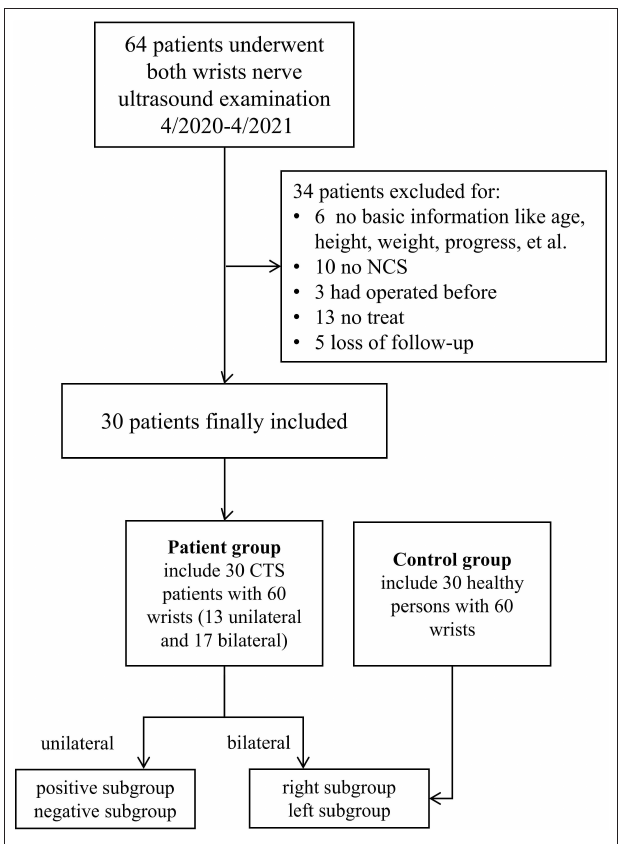
FIGURE 1 | Study flowchart. NCS, nerve conduction study; CTS, carpal tunnel syndrome.